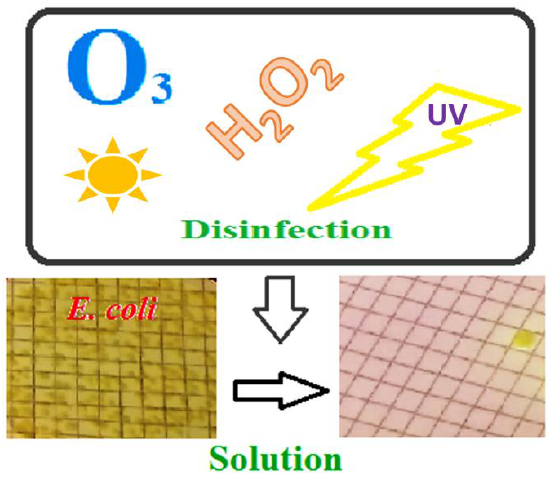
Figure 3. Ozone-aided processes for water disinfection.